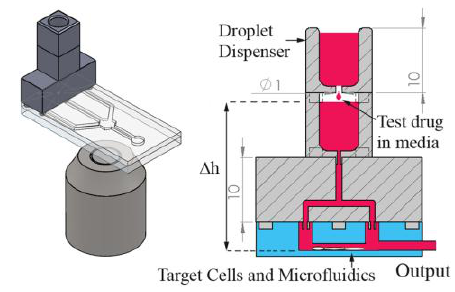
FIGURE 1: Biochip setup and design.